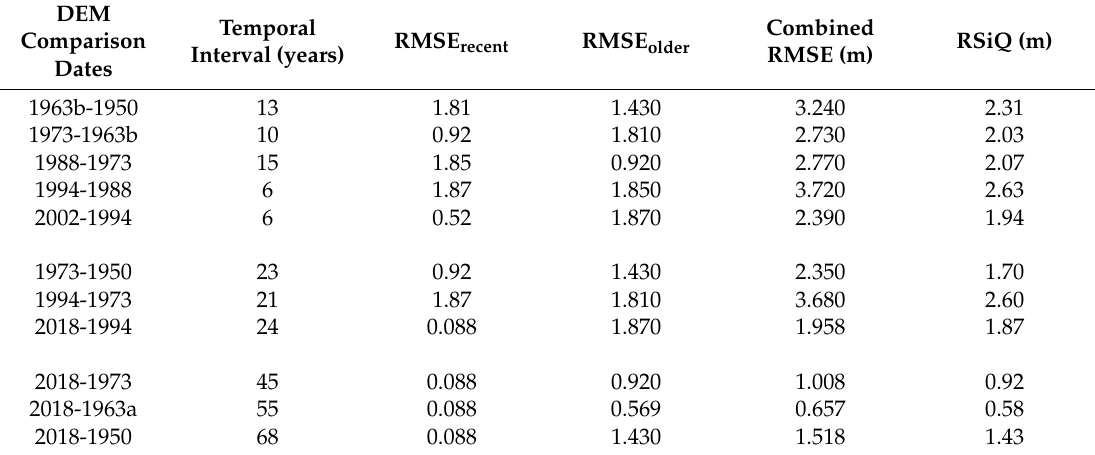
Table 5. Evaluation of topographic change thresholds associated with di ff erent temporal intervals. DEM